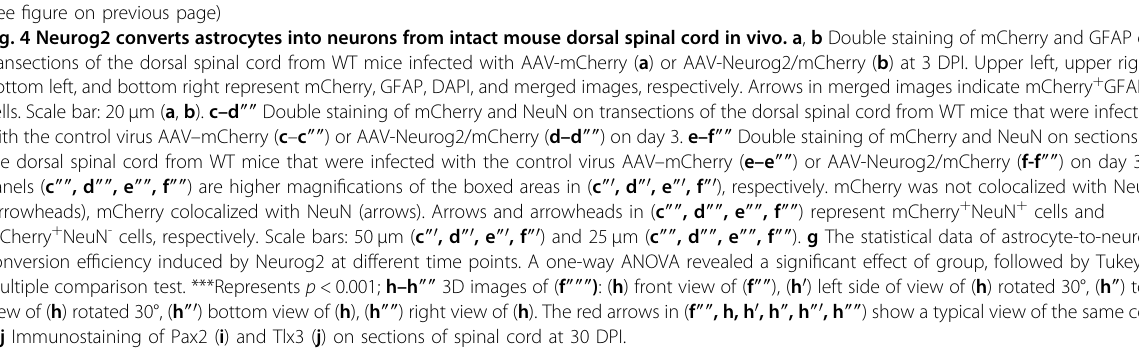
Fig. 4e – e ″″ , g). On the contrary, mCherry colocalized with NeuN in tissue infected with AAV-Neurog2/mCherry, with a percentage up to 80.11 ± 5.42% ( n = 4 mice; Fig. 4f – f ″″ , g, h – h ″″ ). We also found that Neurog2- (50.9 ± 8.8%, n = 3 mice; Fig. 4j) and GABAergic (38.5 ± 8.3%, n = 3 mice; Fig. 4i) neurons.